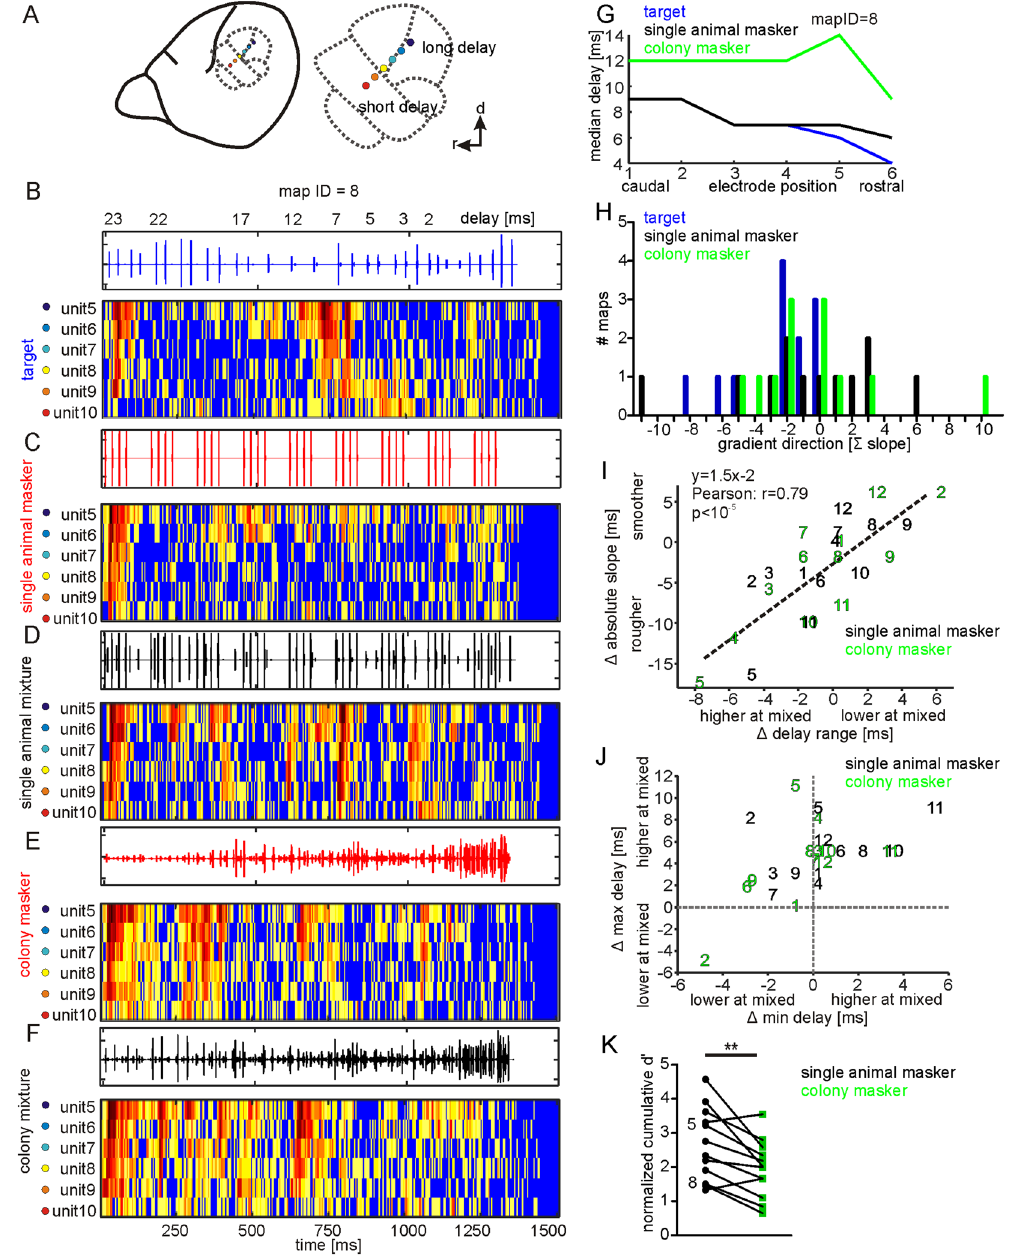
Figure 4. Robustness of chronotopy in the presence of masker stimuli. ( A ) Schematic lateral view on C. perspicillata ’s brain and a magnification of the auditory cortex (dashed lines). ( B – F ) Color-maps represent neuronal activity (binsize = 5 ms) from a cortical map in response to the target ( B ), single animal masker ( C ), single animal mixture ( D ), colony masker ( E ), and colony mixture ( F ) condition. Each row represents a unit. Colored dots indicate electrode positions corresponding to the color code from ( A ). ( G ) Median delays in response to the target (blue), single animal mixture (black), and colony mixture (green) are plotted against the electrode positions for the example map. ( H ) Histogram shows the gradient direction of the maps. Negative values indicate a decrease from long to short delays along the caudo-rostral extent and vice versa. ( I ) For each map, the absolute median delay slopes and the delay range that the map covers were subtracted from each other and plotted for each map. Each number represents a map identifier (ID). The linear regression shows that the map roughness partially depends on the delay range. ( J ) The change in maximum delay is plotted against the change in minimum delay for each map and mixture condition. ( K ) Cumulative map d ′ values are plotted for both mixture situations. The map-IDs of the example maps from ( A – F ) and Fig. S4 are indicated adjacent to the black data